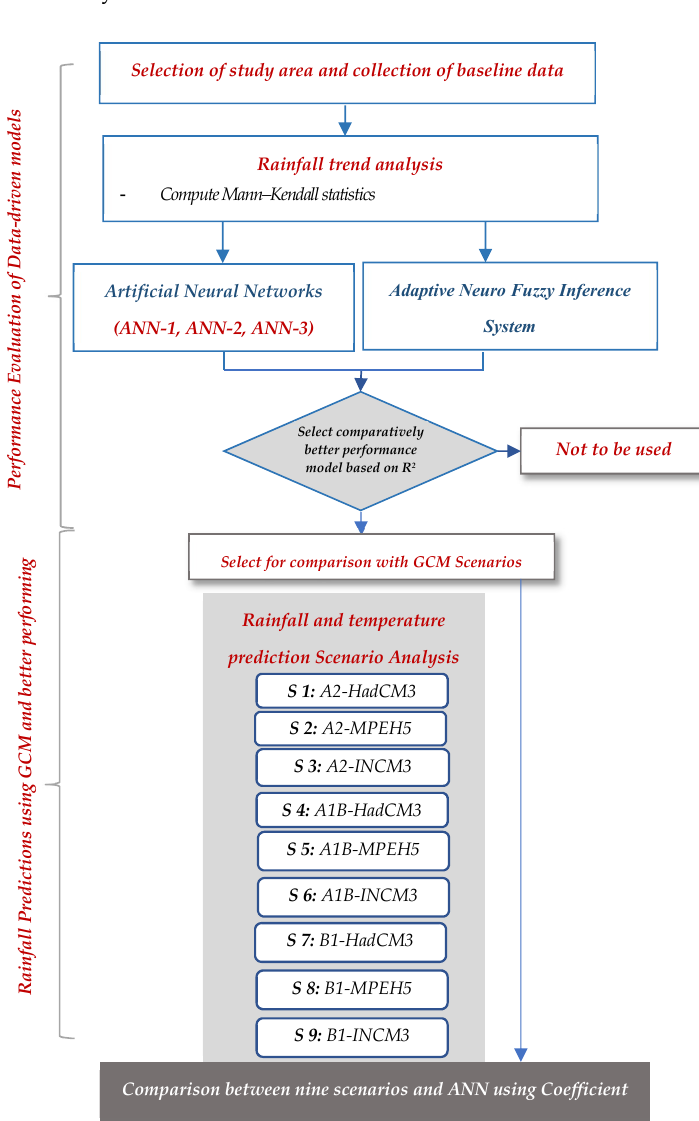
Figure 1. Framework for methodology.